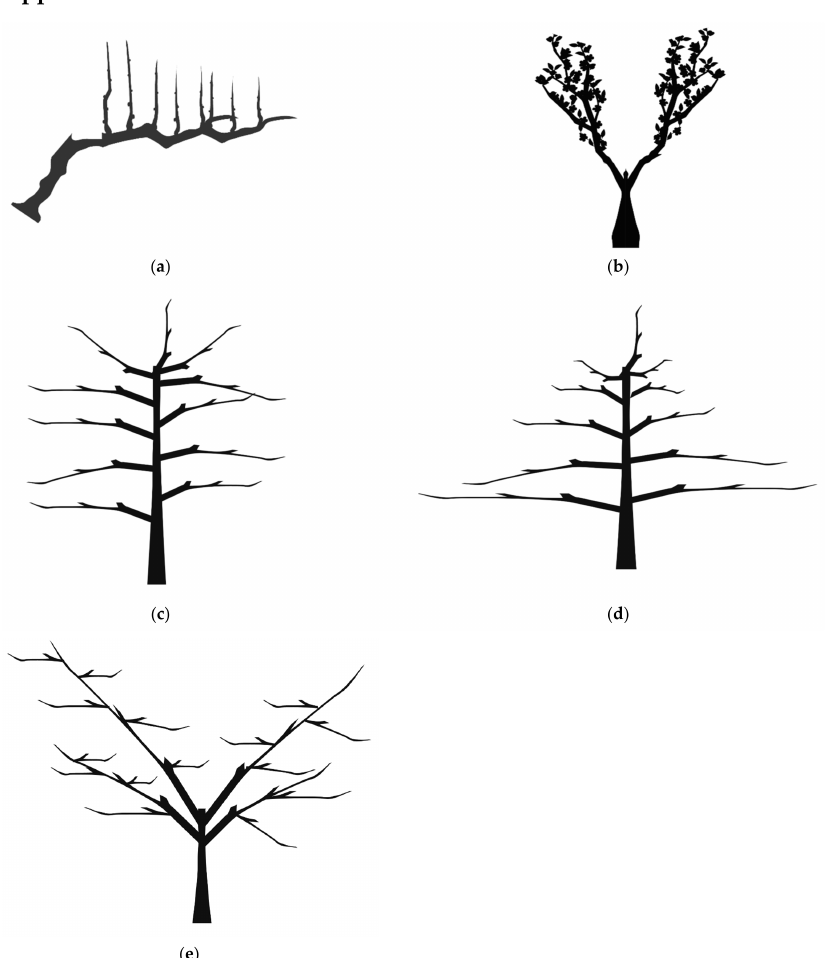
Figure A1. Illustrations of the UFO ( a ), BB ( b ), SSA ( c ), TSA ( d ) and SL ( e ) training systems. (Source: Created with BioRender.com).